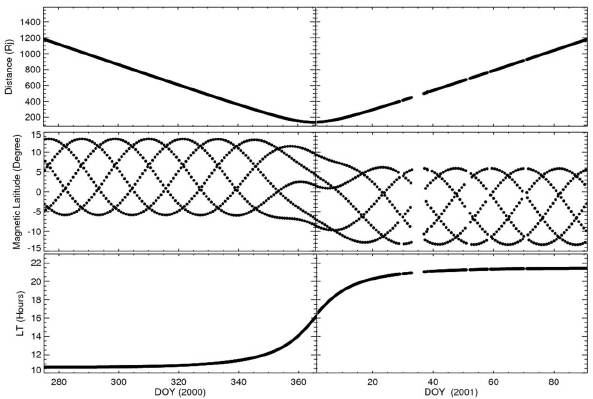
Figure 1. Variation of Cassini orbital parameters versus the DOY during the Jupiter flyby. The investigated period is from 1 Octo- ber 2000 (DOY 265) to 31 March 2001 (DOY 090), and the clos- est approach to the planet was on 27 December 2001. The distance between Jupiter and the spacecraft (expressed in Jovian radii), the magnetic latitude (in degrees) and local time (in hours) are shown, respectively, in the top, middle and bottom